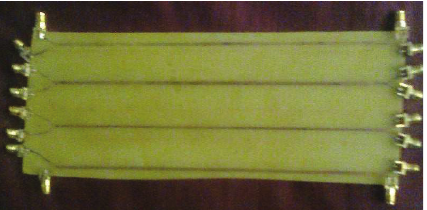
Figure 8: Photograph of test board with various microstripline structures.